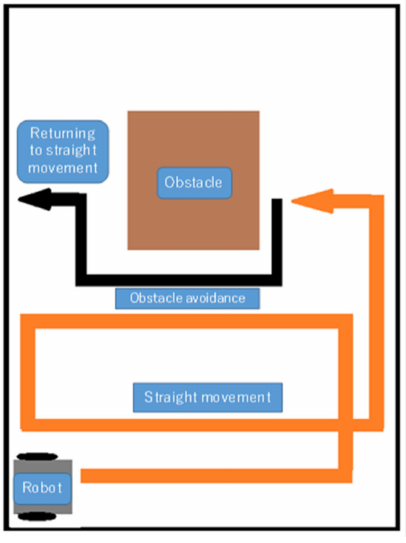
Figure 1. Robot movement to touch the majority of the moving